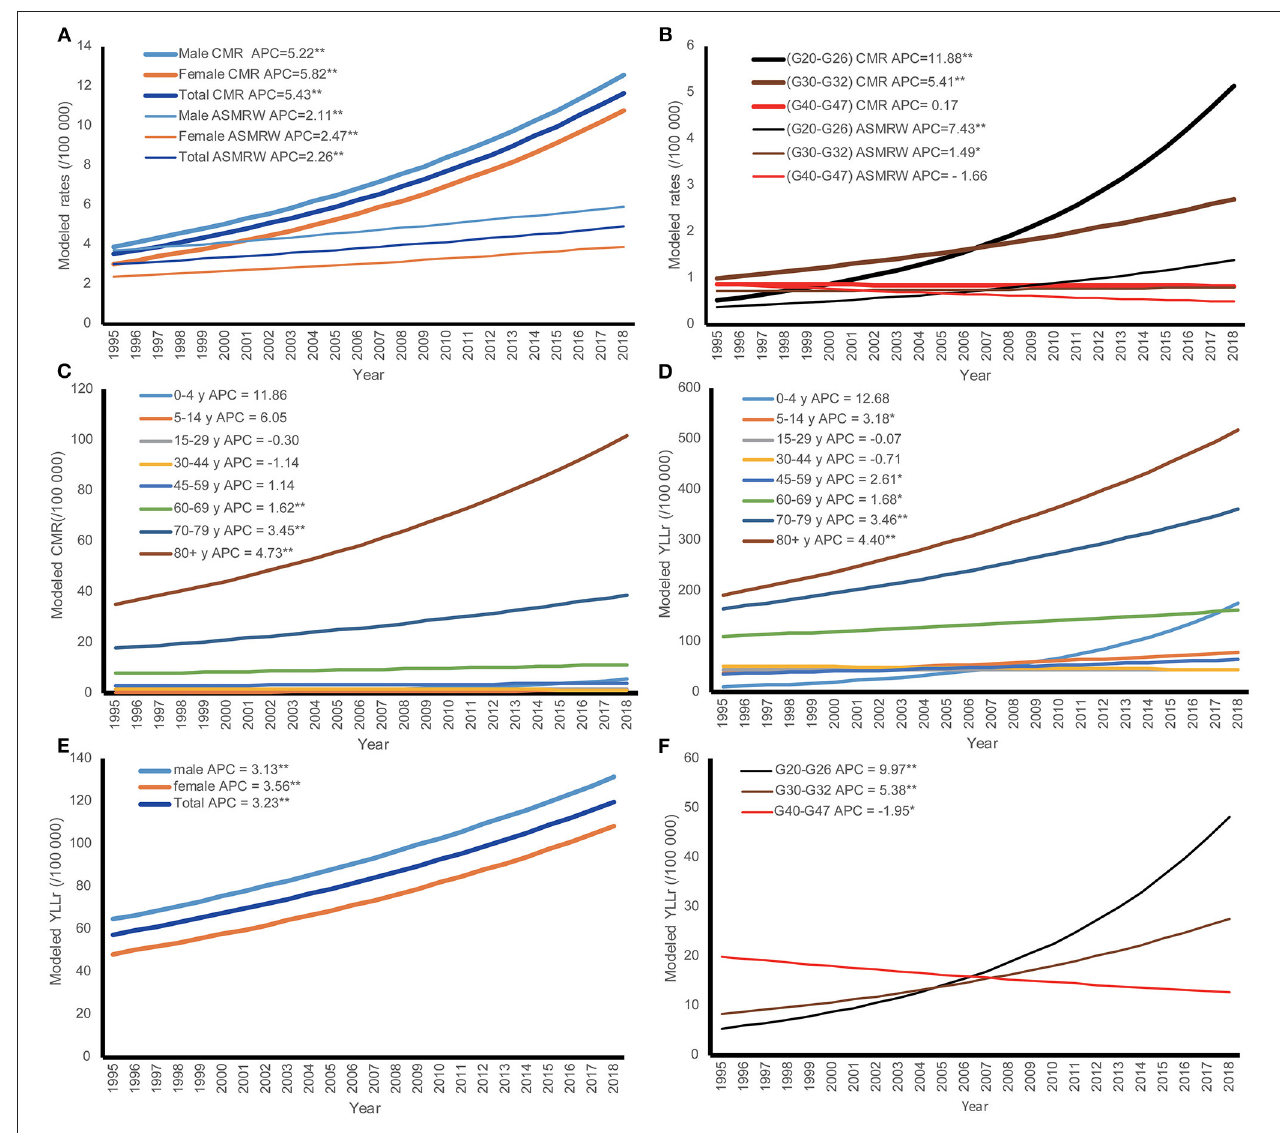
FIGURE 1 | The trends in CMR, ASMRW, and YLL of persons with underlying cause of death from selected neurological disorders in genders, major pathology types, and age groups in Pudong New Area, Shanghai, China, 1995–2018. (A) Trends in CMR and ASMRW in genders; (B) trends in CMR and ASMRW in major pathology types; (C) trends in CMR among different age groups; (D) trends in YLL among different age groups; (E) trends in YLL in genders; (F) trends in YLL in major pathology types. ASMRW, age-standardized mortality rate by Segi’s world standard population (per 100,000); CMR, crude mortality rate (per 100,000); G20–G26, extrapyramidal and movement disorders; G30–G32, other degenerative diseases of the nervous system; G40–G47, episodic and paroxysmal disorders. ** P < 0.001; * P <